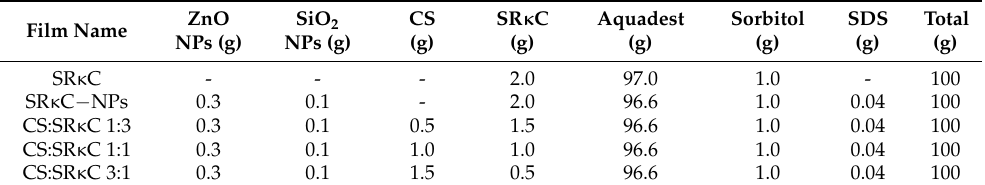
Table 1. Composition of bionanocomposite